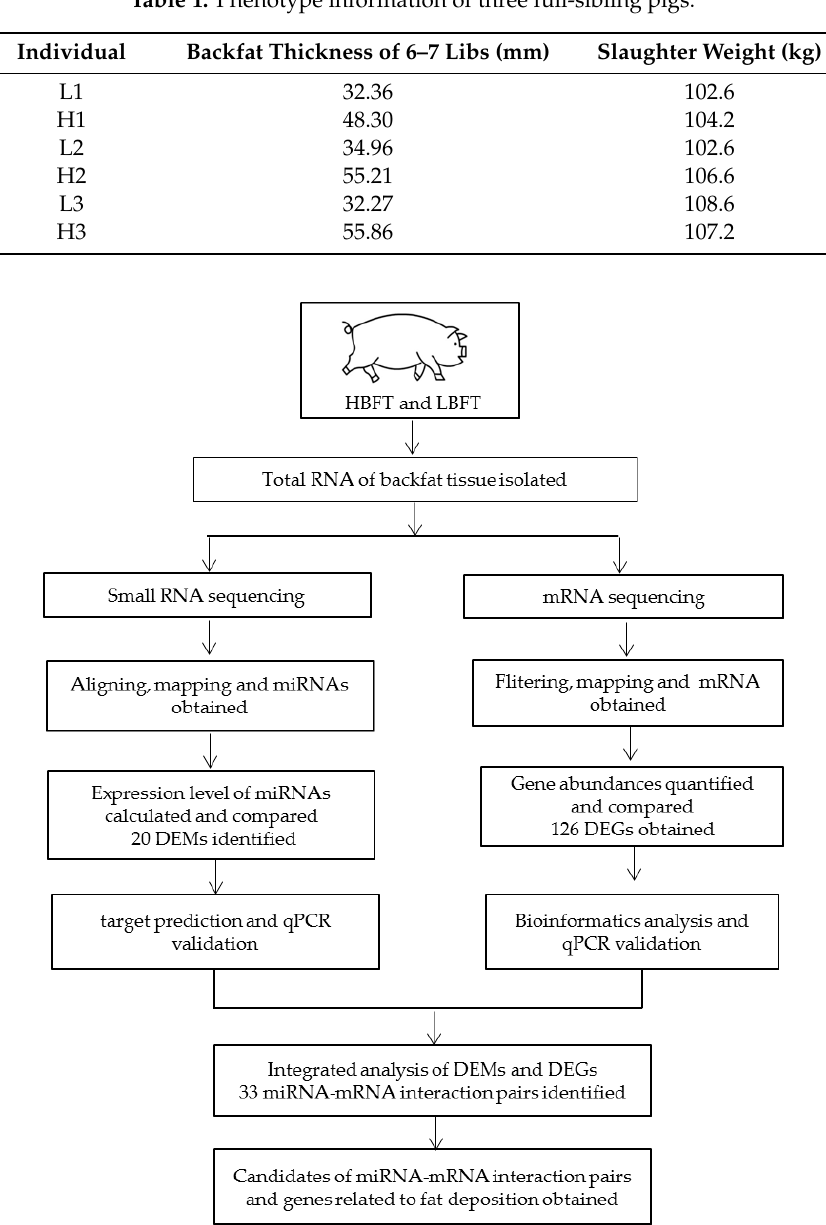
Figure 1. Workflow of the study with the experimental design and main results.